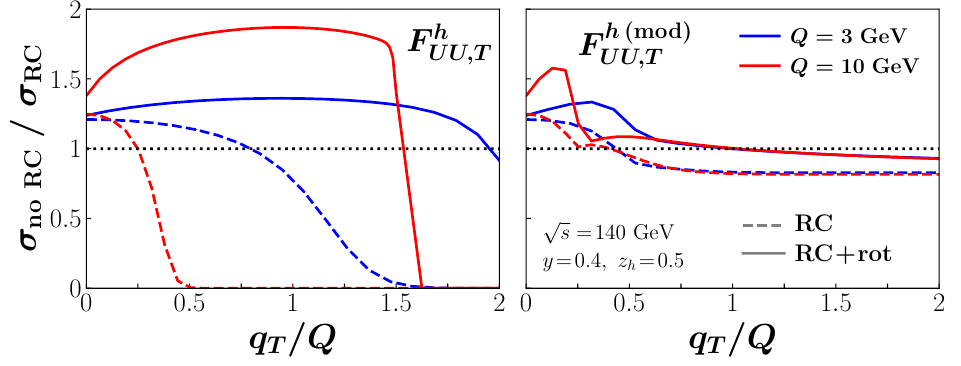
Figure 20 . Ratios of unpolarized SIDIS cross sections without radiation (“no RC”) to those including QED effects, as a function of q T /Q , for the F h structure function from ref. [69] using UU,T the Gaussian ansatz in the TMD framework (left) and with the modified F h (mod) as in eq. (4.6) UU,T √ (right), for s = 140 GeV, y = 0 . 4 and z h = 0 . 5 , at Q = 3 GeV (blue lines) and 10 GeV (red lines). The full calculation with QED radiation (“RC+rot”, solid lines) is compared with that removing the QED rotational effects induced to the transverse momentum in Breit frame (“RC”, dashed